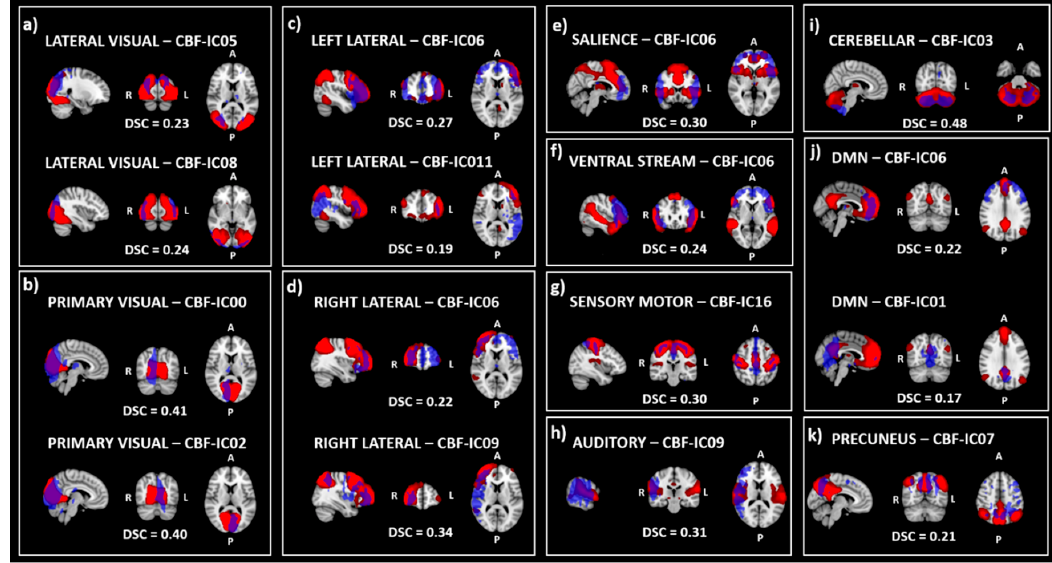
Figure 2. The figure shows the comparison between CBF-ICs (in blue) and the resting state network (RSN) (in red) derived from the whole ASL and rsfMRI sample, respectively. Specifically, the overlap between CBF-ICs and lateral visual network ( a ), primary visual network ( b ), left and right lateral networks ( c , d ), salience network ( e ), ventral network ( f ), sensory-motor network ( g ), auditory network ( h ), cerebellum ( i ), default mode network ( j ), and precuneus network ( k ) are reported. Legend: RSN = Resting state network; CBF-ICs = independent components derived from CBF maps; DSC = Dice Similarity Coefficient; DMN = Default mode network. The overlap between the CBF-ICs and the VTs is shown in Figure 3.